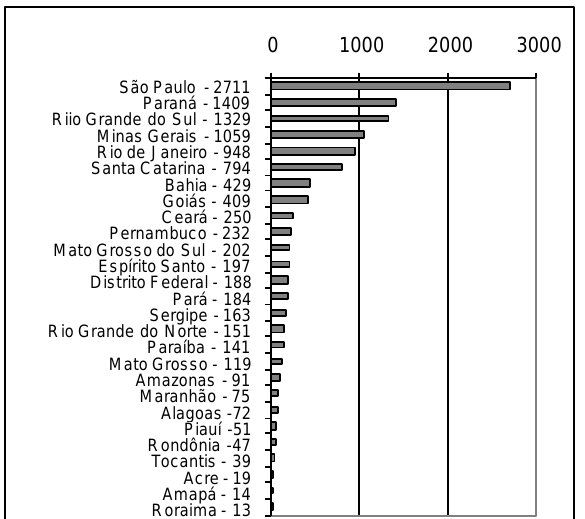
Figura 6. Especialistas por unidades da federação. Fonte: Portal da Inovação. Acesso em: 20/11/2008.